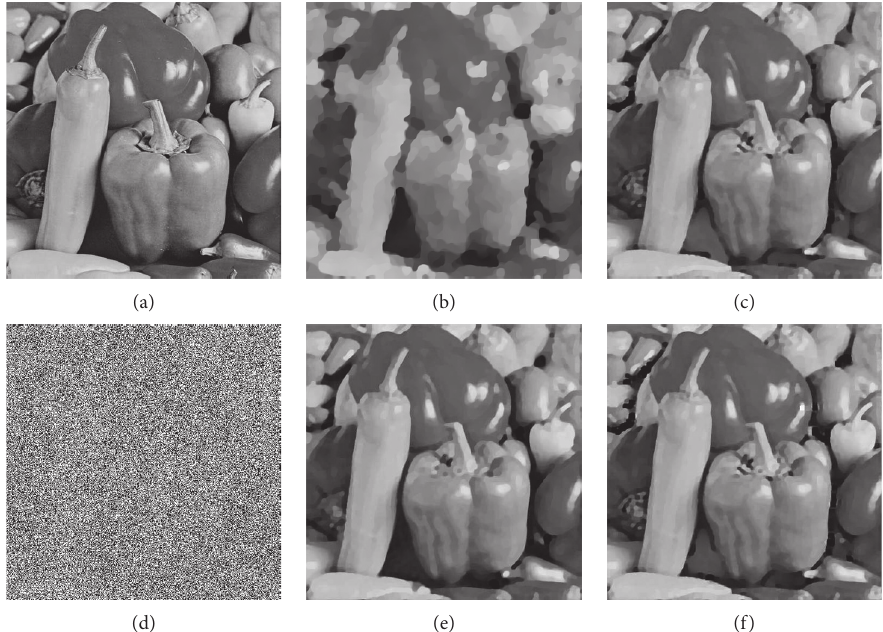
Figure 10: The recovery results (Peppers 512) by Average blur with 90% SP noise. (a) Original. (b) TVL1, PSNR � 19.2008. (c) TVSCAD, PSNR � 24.3041. (d) Average blur (lev � 0.9). (e) TVLog, PSNR � 25.2903. (f) LogTVSCAD, PSNR � 25.7948.